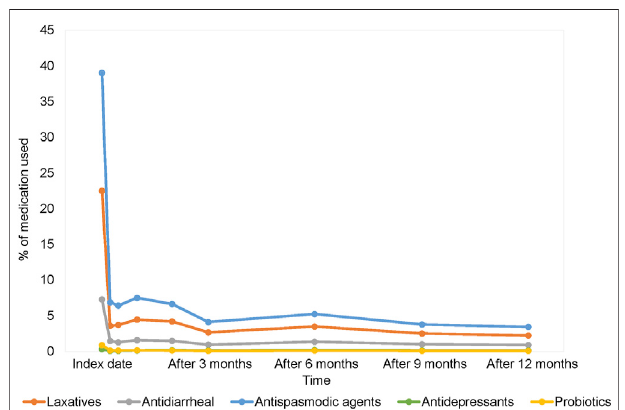
FIGURE 3 | The trend in different pharmacological type of